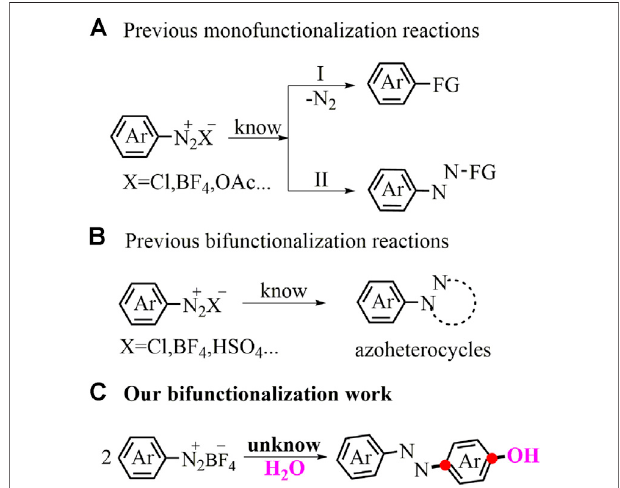
FIGURE 1 | Functionalizations of aryldiazonium salts.